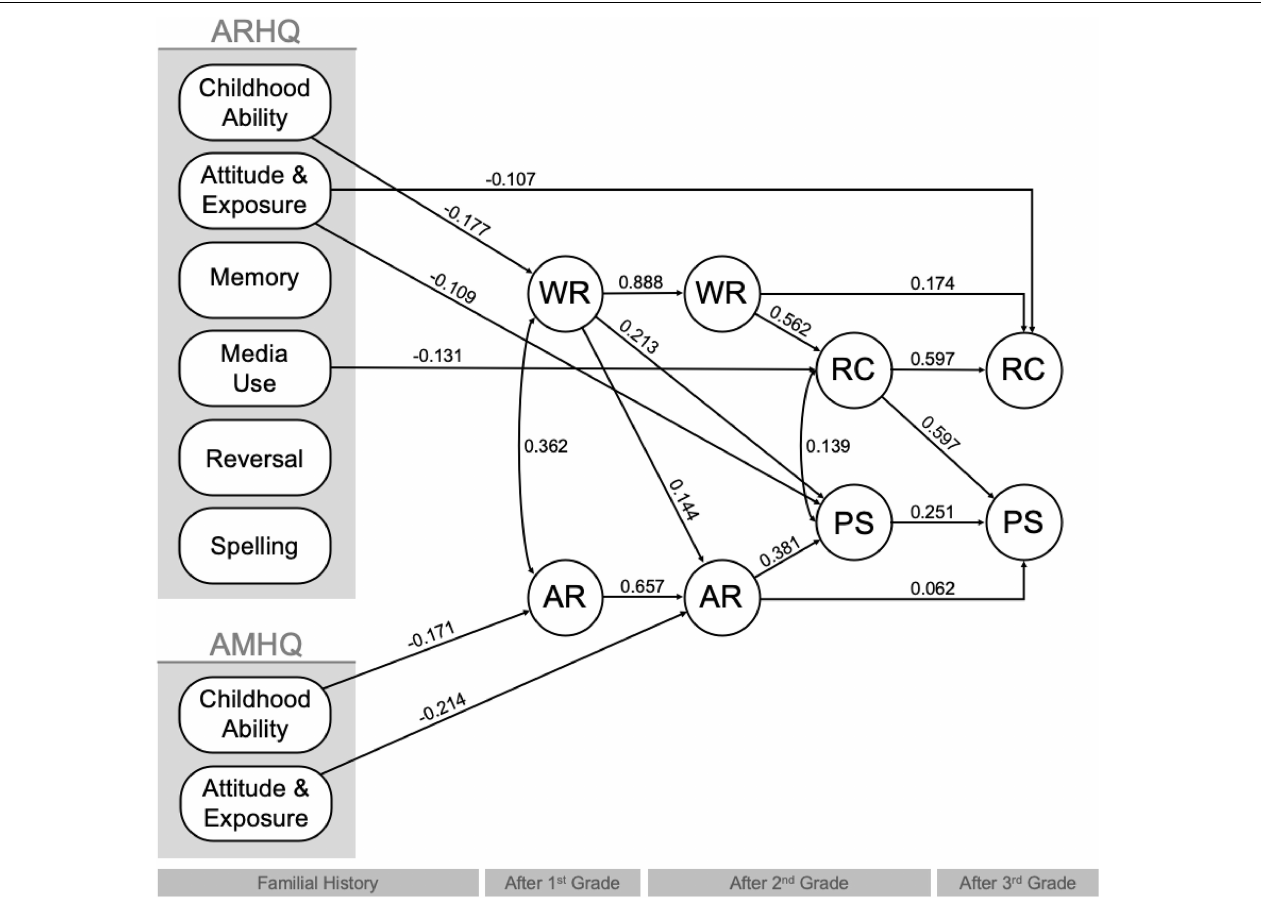
FIGURE 2 | Final path model for the effects of individual factors derived from the ARHQ and AMH on measures of children’s core academic skills [word reading (WR) and arithmetic calculation (AR)] after first and second grades, and performance on complex tasks [reading comprehension (RC) and problem solving (PS)] after second and third grades. Parents’ level of education attainment and children’s demographic information [age, IQ (at baseline), sex, and school information (Title 1 Status)] were included as covariates. (All paths with coefficients shown met p < 0.05. Covariances among factors from the ARHQ and AMHQ can be found in Supplementary Table 10 . The directionality of the computed factor scores remain consistent with the that of the questions on each scale – that is, higher scores on any factors extracted from the ARHQ or AMHQ indicate, e.g., increased difficulties with learning to read or do simple